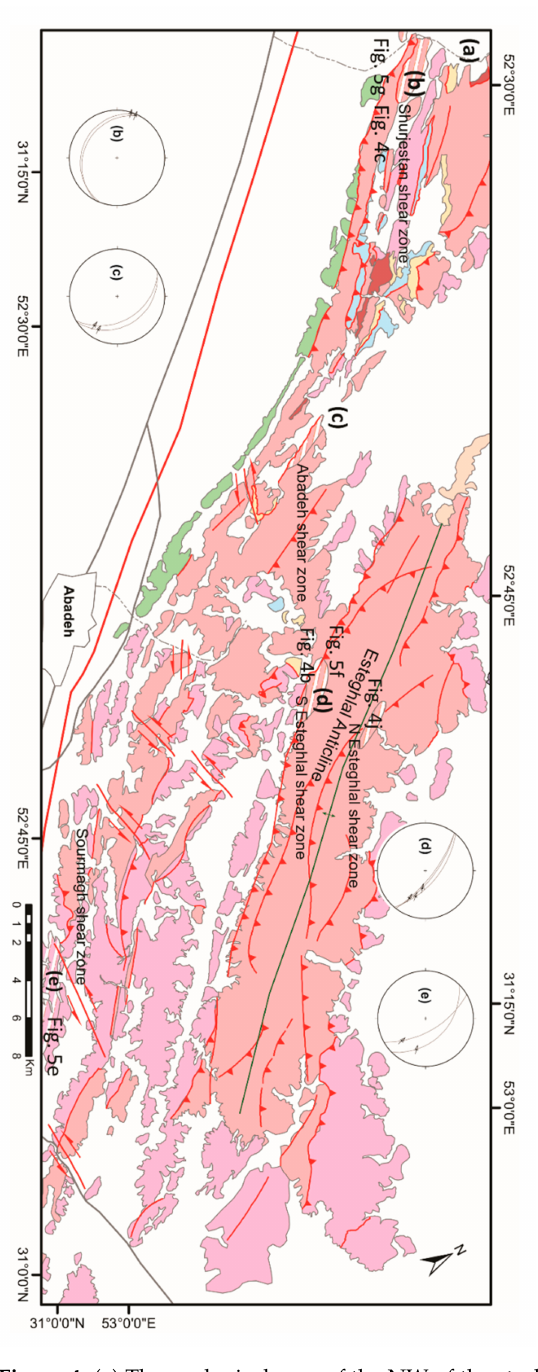
Figure 4. ( a ) The geological map of the NW of the study area, modified after [37]. The legend is the same as Figure 3; ( b – e ) Stereographic projection from the lower hemisphere showing the orientation of the foliations, stretching lineations, and the shear senses of the Shurjestan ( b ), Abadeh ( c ), South Esteghlal ( d ), and Sourmagh ( e ) shear zones,